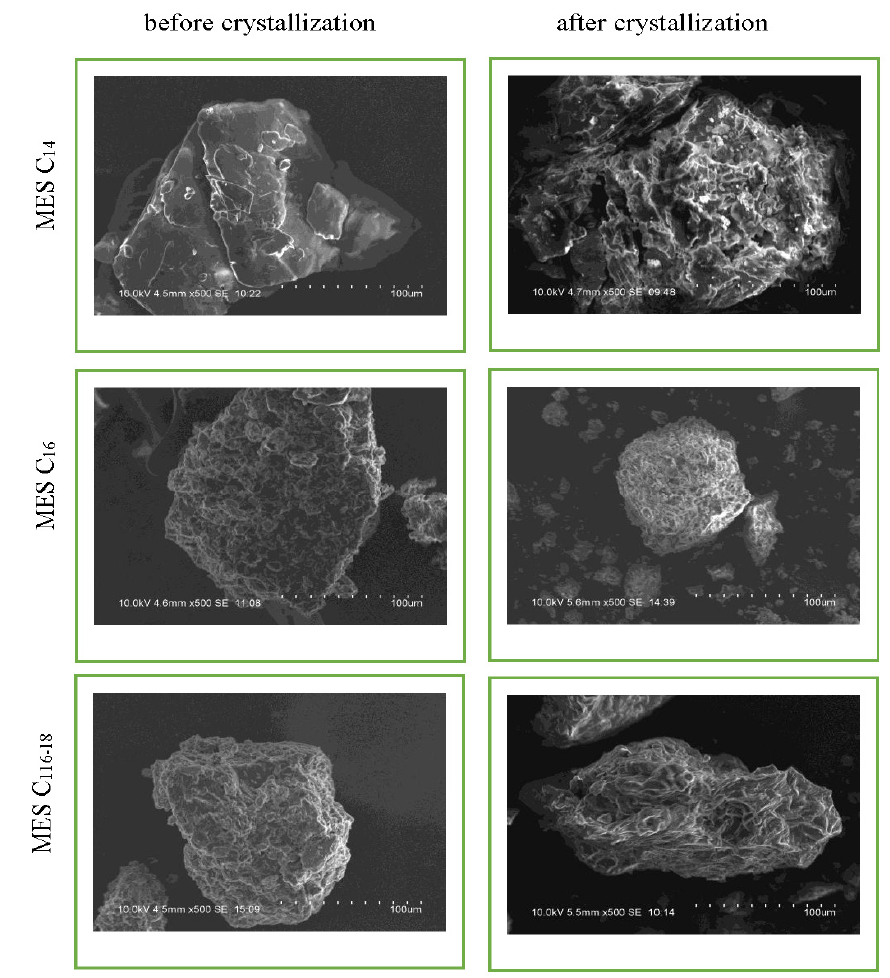
Figure 6. Surface morphology of the MES before and after repeated crystallization. Table 4. Elemental analyses of MES.